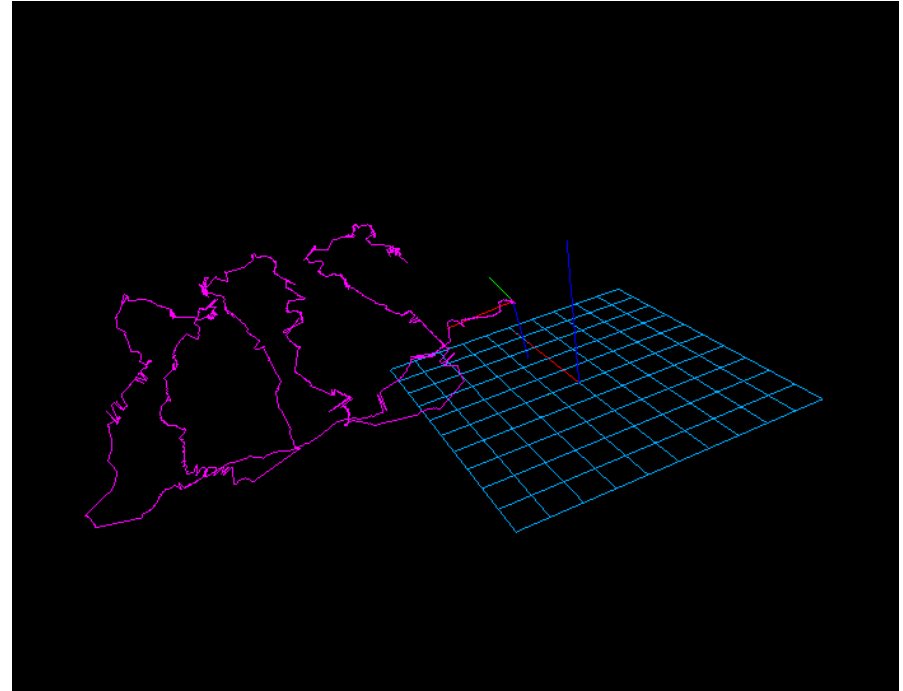
Figure 7. The 3D trajectory estimated by the